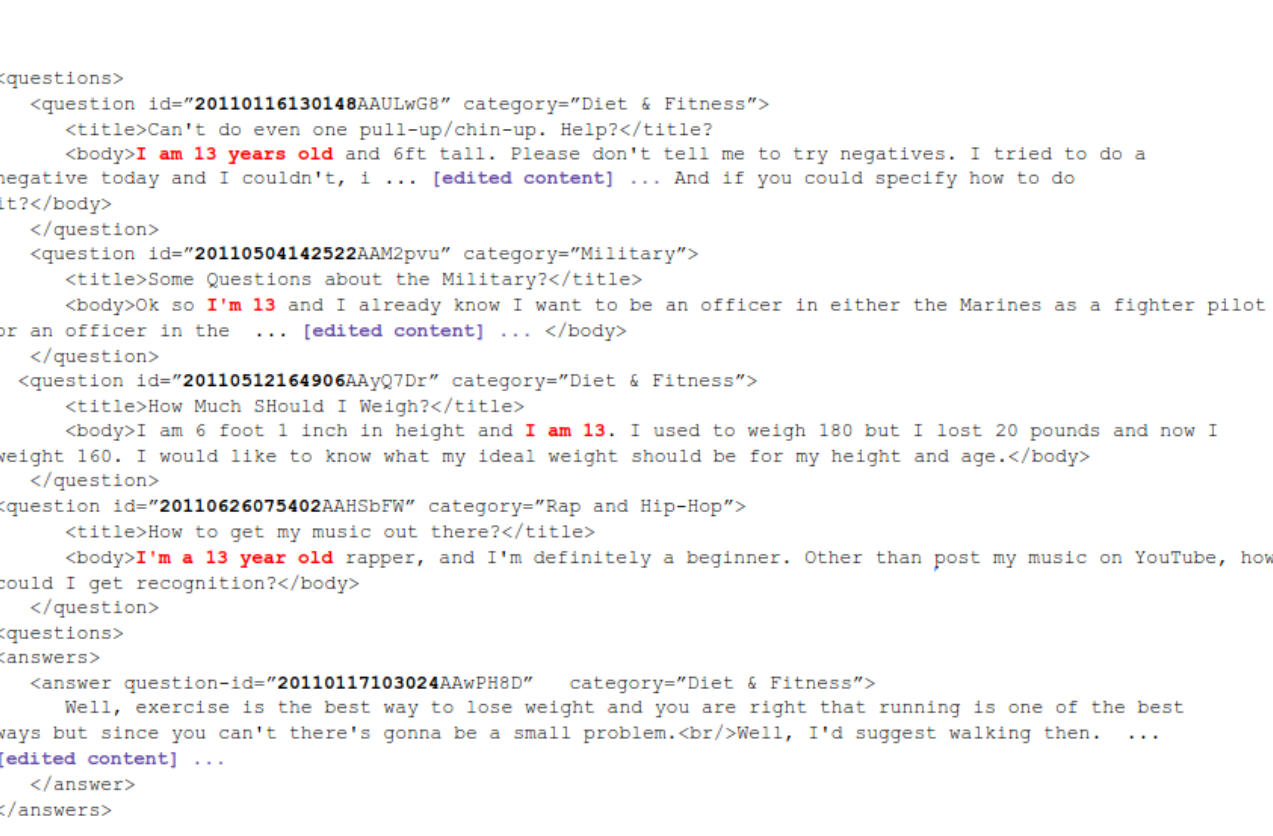
Figure 3. An instructive user record. In bold red, phrases used for inferring the age, and in bold black,